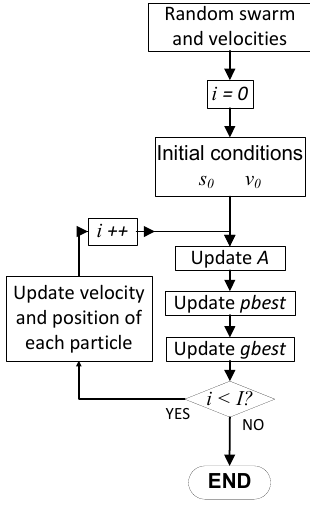
Figure 1. MOPSO algorithm flowchart.